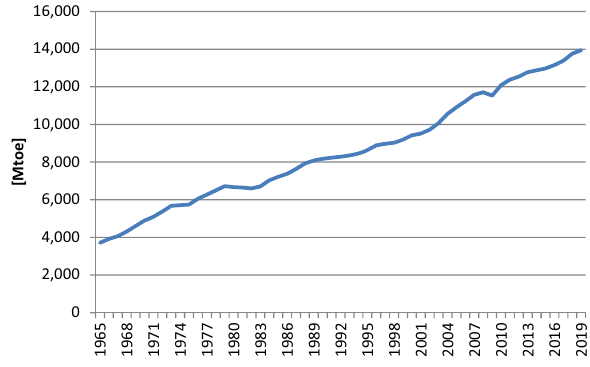
Figure 1: Global primary energy consumption in the years 1965 – 2019. Source: own work based on ref. [ 2 ] .